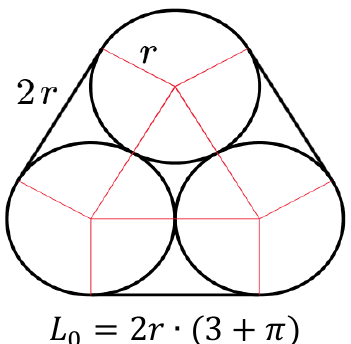
Figure 2. Cylinders connected by an inelastic thread.